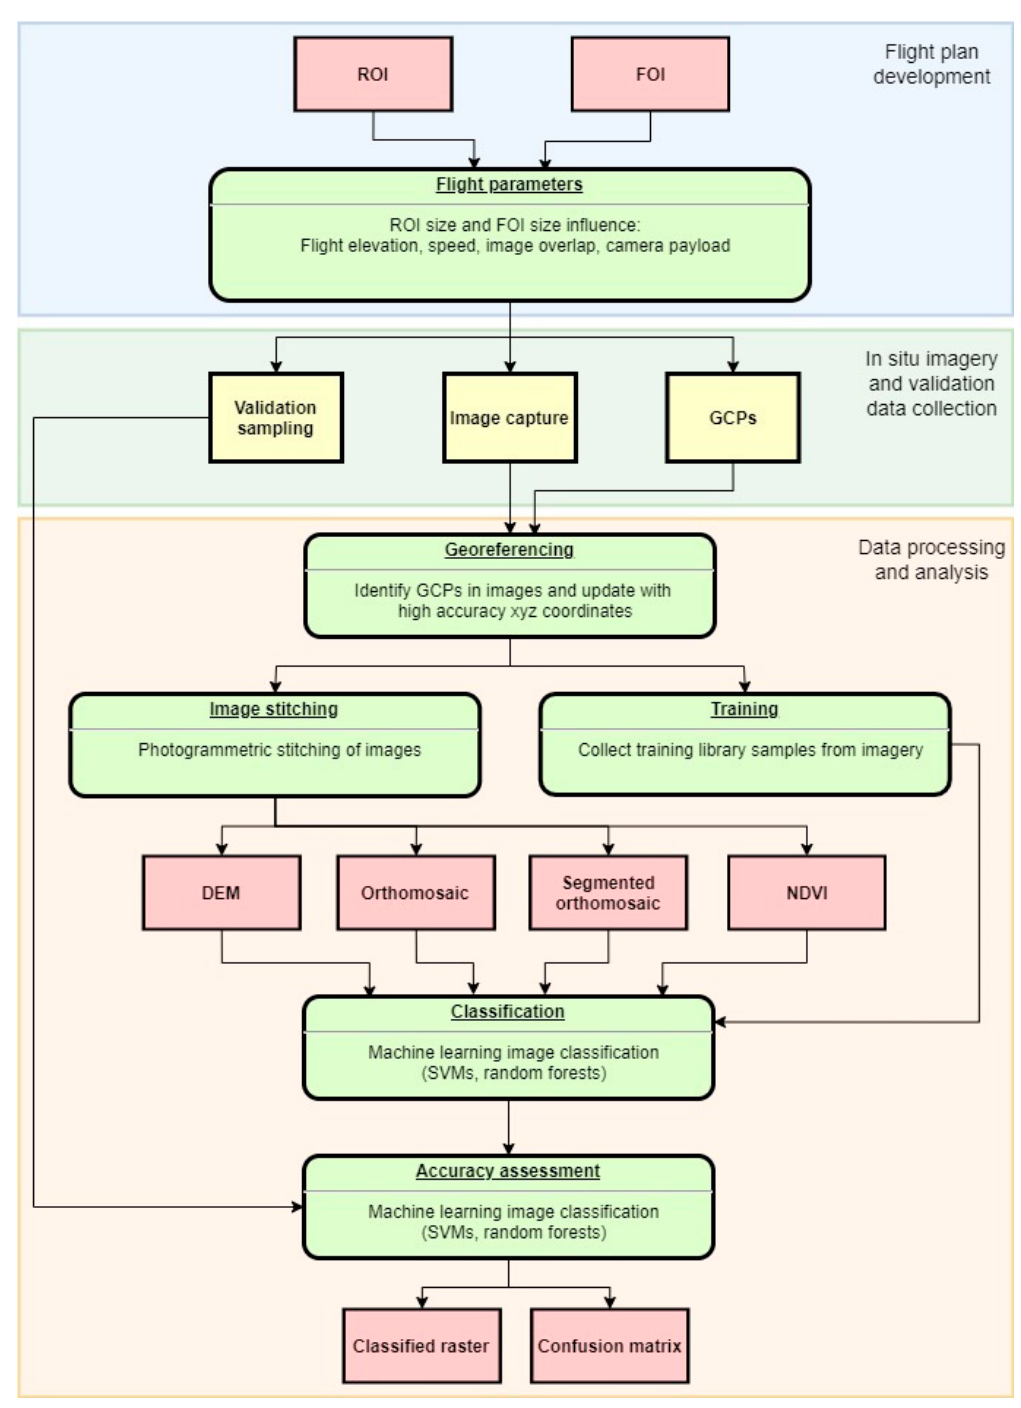
Figure 2. Workflow for planning UAV surveys, key datasets to be collected in situ and the steps for analysis and accuracy assessment of classified outputs. The size of the Region of Interest (ROI) and Features of Interest (FOI) are key in determining flight parameters, particularly the altitude of image capture. For example, a large ROI and very small FOI may be incompatible as the required ground pixel size would require low altitude mapping, which can be difficult to achieve over large areas. GCP = Ground Control Points; DEM = Digital Elevation Model; SVM = Support Vector Machines. Multivariate species data were analysed by averaging the coverage of each algal taxon over the 5 plots from replicate clips (100 m 2 area). Comparisons of the large brown algal species were done on the square root of density using pairwise Bray–Curtis resem- blance matrices. These matrices identify the similarity of multivariate datasets to describe